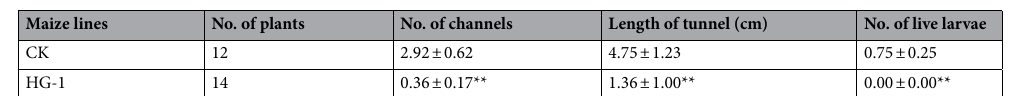
Table 2. Insect resistance of transgenic inbred lines against Asian corn borer. Means (± SE) within a column followed by different letters are significantly different ( t -test, ** P < 0.01).